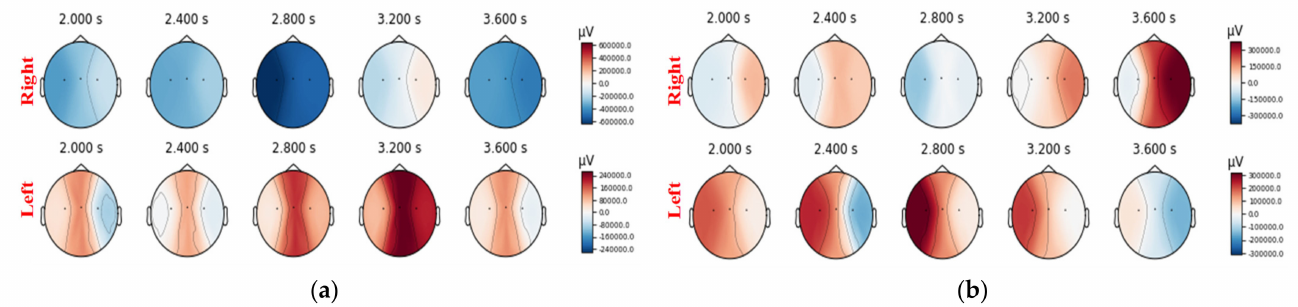
Figure 1. The power spectral density (PSD) of Subject 46 performing motor imagery at different times: the charts are the power spectra (blue represents negative, and red represents positive). The EEG signals were provided by an open dataset with BCI illiterate subjects [8] and they were recorded in two different sessions on different days. ( a ) and ( b ) are the PSD diagrams of Subject 46 in session 1 and session 2, respectively. The classification accuracies of Subject 46 were 53% and 58% in the two sessions, respectively, so the subject was classified as BCI illiterate.